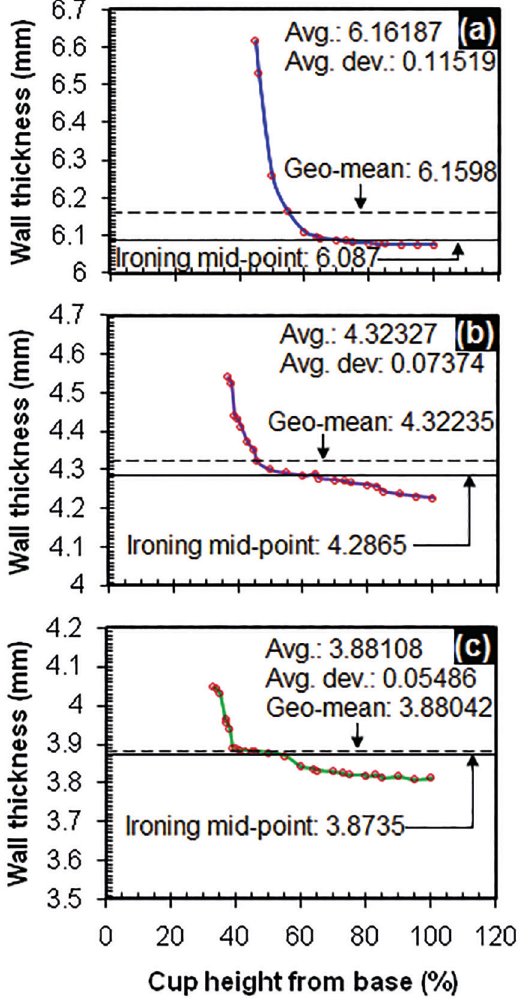
Figure 7: Graphical showing of cup wall thickness distribution, (a) 1 st draw, (b) 2 nd draw and (c) 3 rd